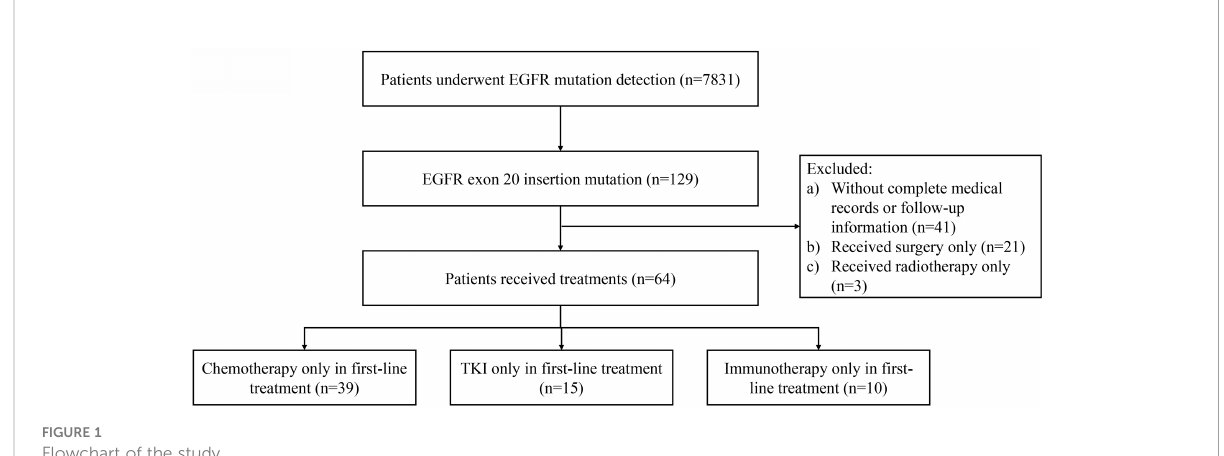
FIGURE 1 Flowchart of the